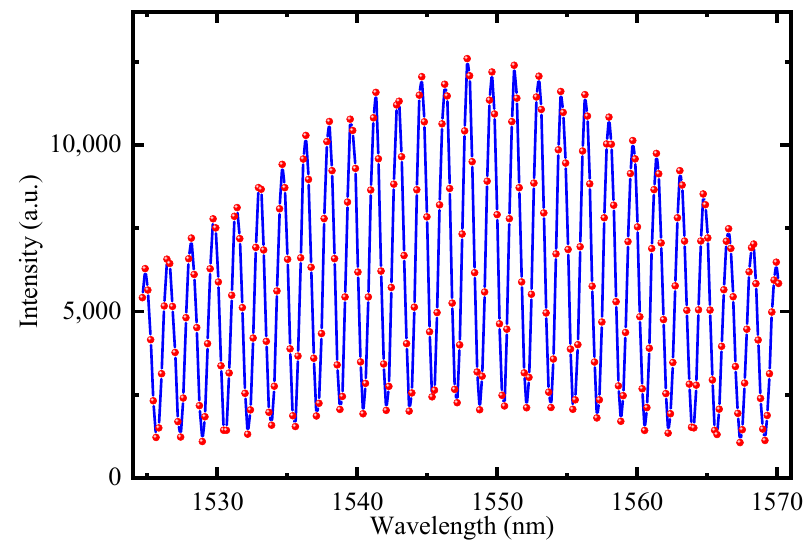
Figure 5. Interference spectrum of the FOM.